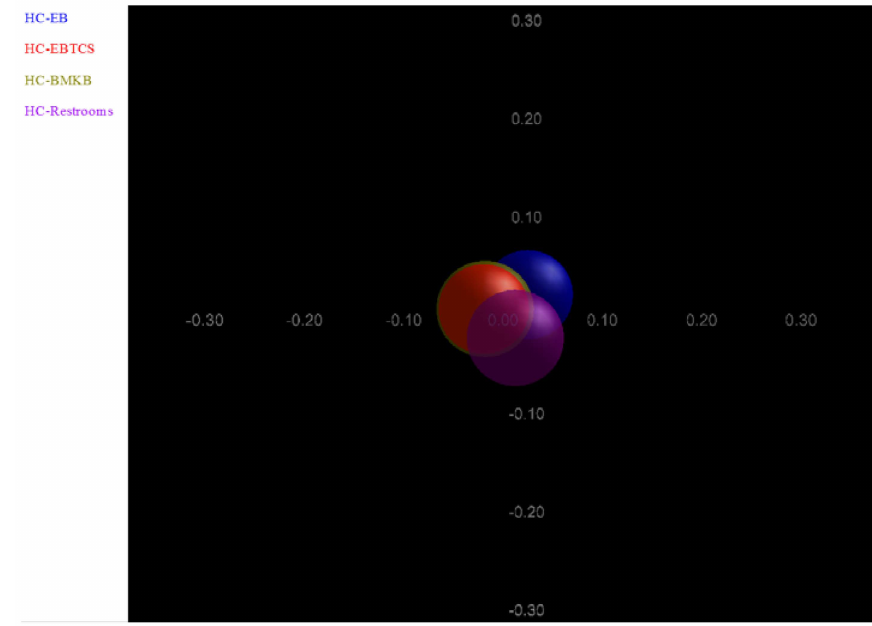
Figure 4. Principal Coordinates Analysis (PCoA) analysis of the microbiome of each surface sample based upon Fast UniFrac method with normalization option. Different colored symbols are indicative of the various